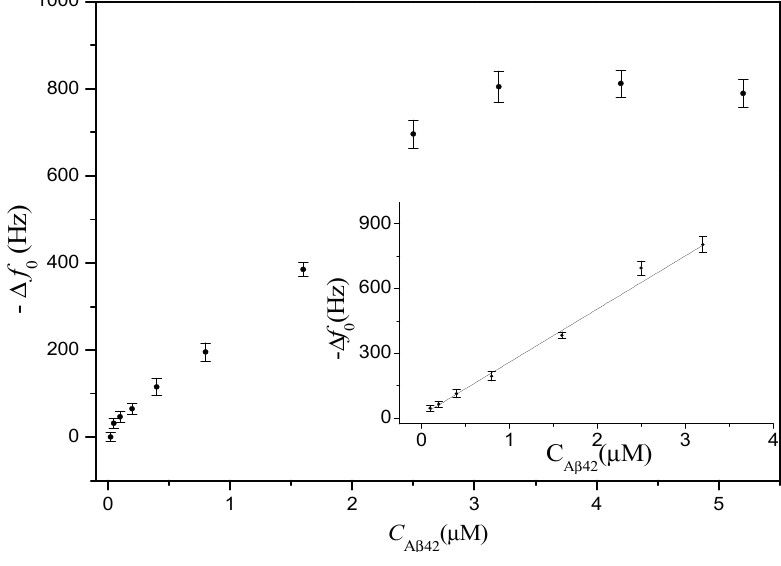
Figure 5. The response frequency shift for on-chip determination of different concentrations of A β 42 in PBS. Inset figure is a calibration curve of A β 42